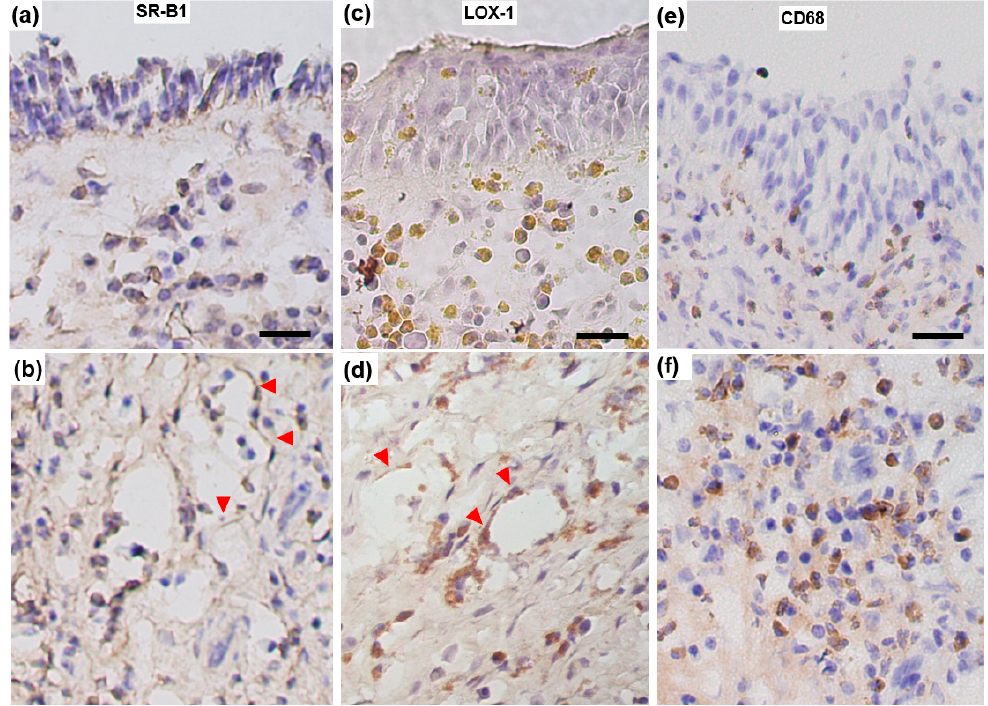
Figure 4. Representative immunohistological images showing SR-B1 ( a , b ), LOX-1 ( c , d ), and CD68 ( e , f ) expression in ethmoid sinus mucosa sampled from a CRSwNP patient. Vascular endothelial cells (arrowheads) are stained positively both for SR-B1 and LOX-1. In contrast, numerous submucosal inflammatory cells show intense positive staining for LOX-1 compared to that for SR-B1. Scale bar: 20 µm.